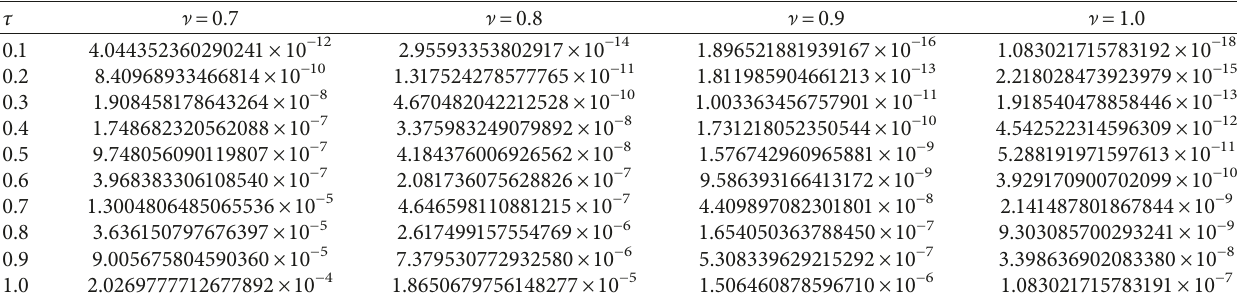
Table 10: The recurrence error of the 5th approximate solution of the imaginary part in Example